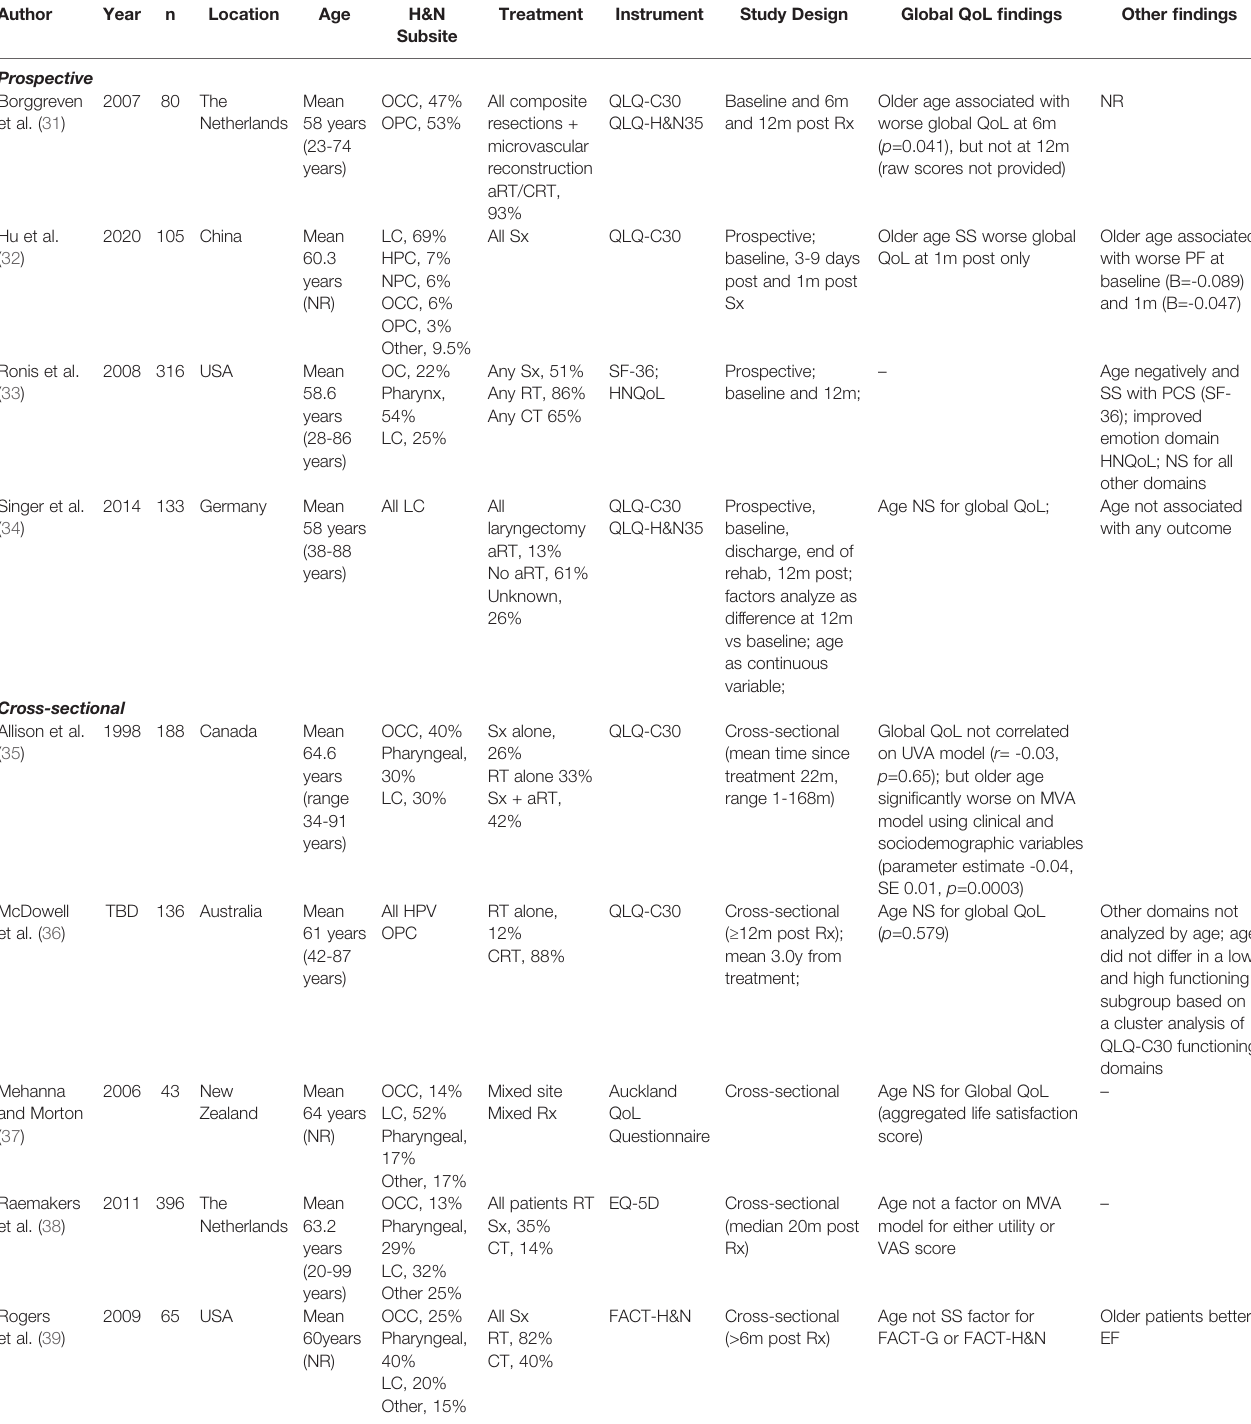
TABLE 5 | Studies reporting age-related differences in health-related quality age in HNSCC (age analyzed as a continuous